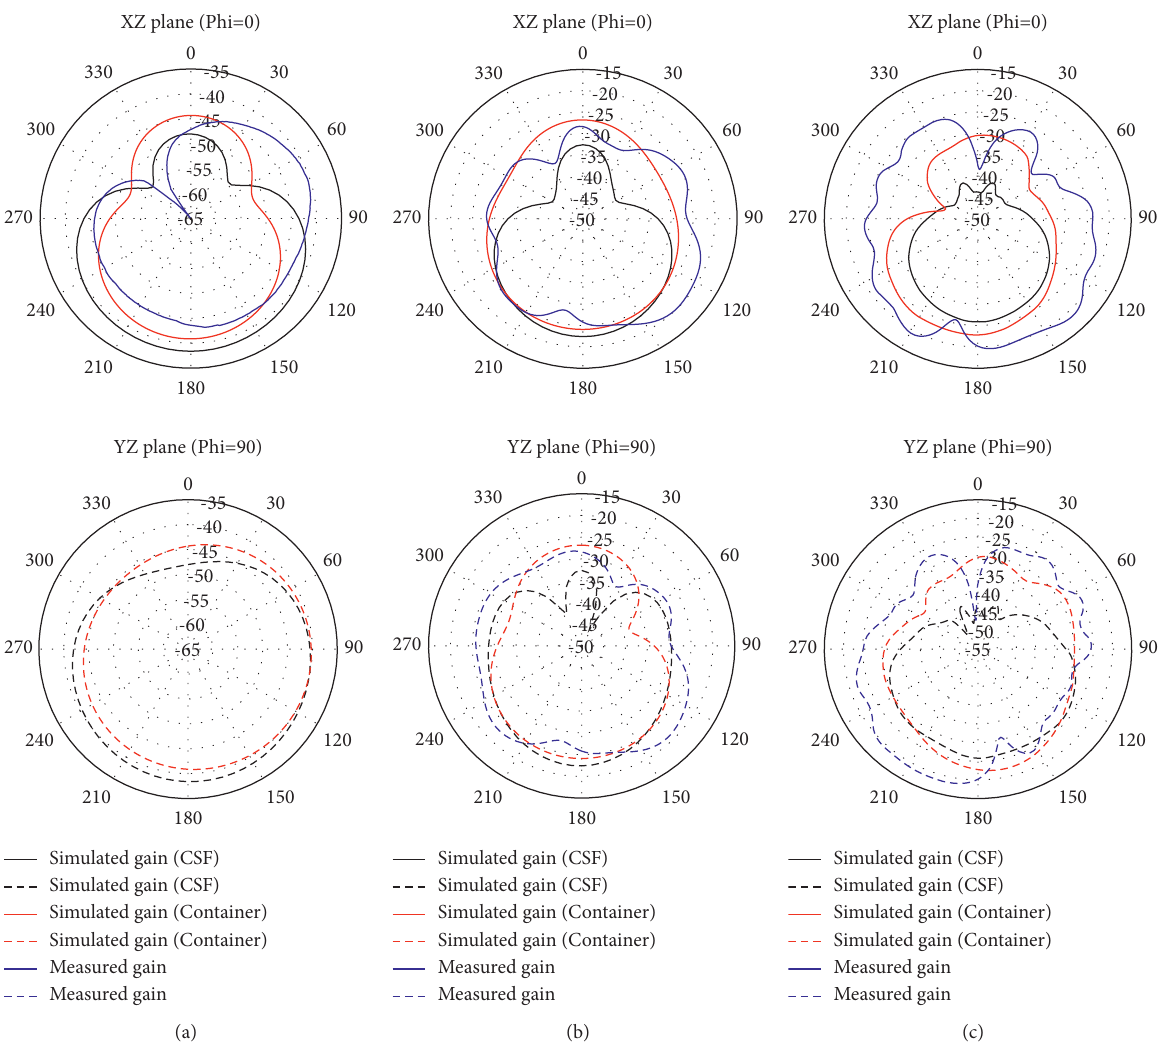
Figure 10: Simulated and measured antenna gain (dBi) pattern at the XZ plane and YZ plane for the frequency of (a) 402MHz, (b) 902MHz, and (c)